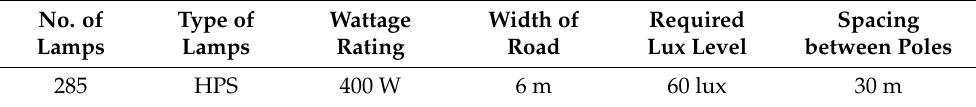
Table 1. Technical Details of Street Lighting System inside